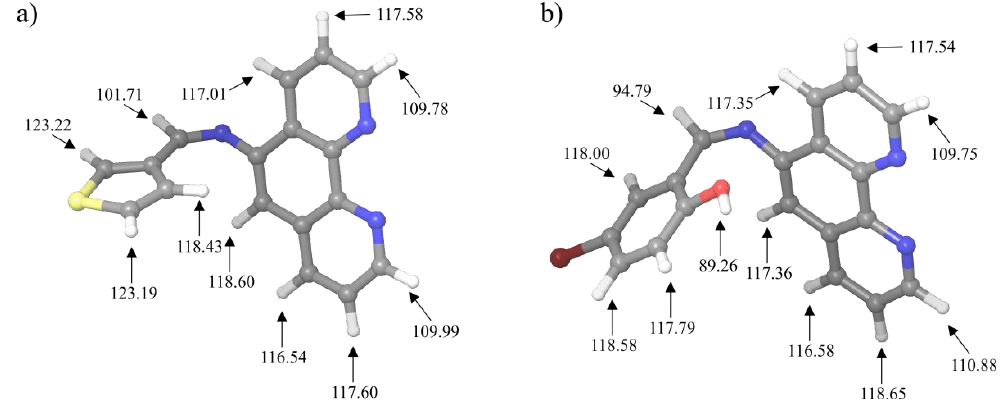
Figure 4. H-BDE values of ( a ) PTM and ( b ) PIB.